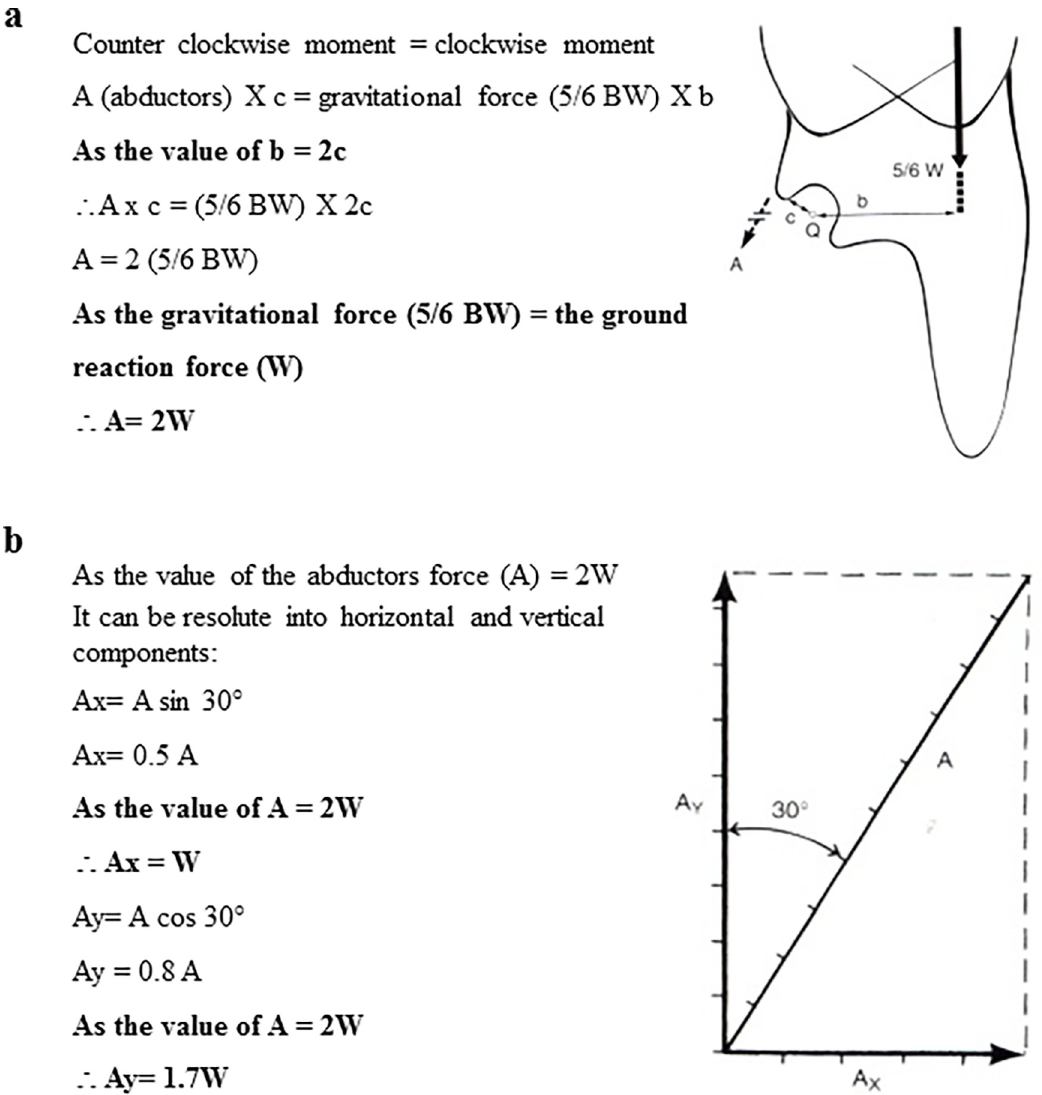
Fig 5. The interaction effect of ramp and gender on the hip forces (a) Calculation to derive the relationship between the gravitational force and the internal hip joint moment during single limb support. (b) The horizontal and the vertical components of the abductors force “A” (Adapted from Frankel and Nordin, 2020)